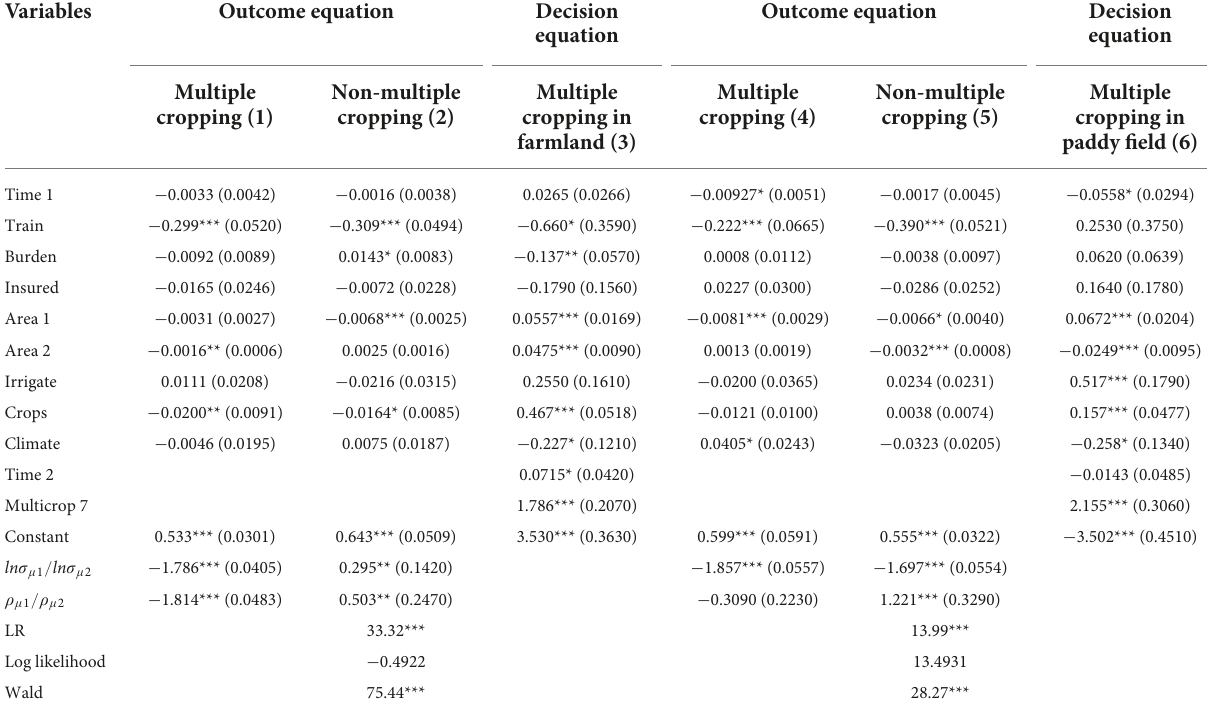
TABLE 2 Estimated results of the endogenous conversion model for multiple